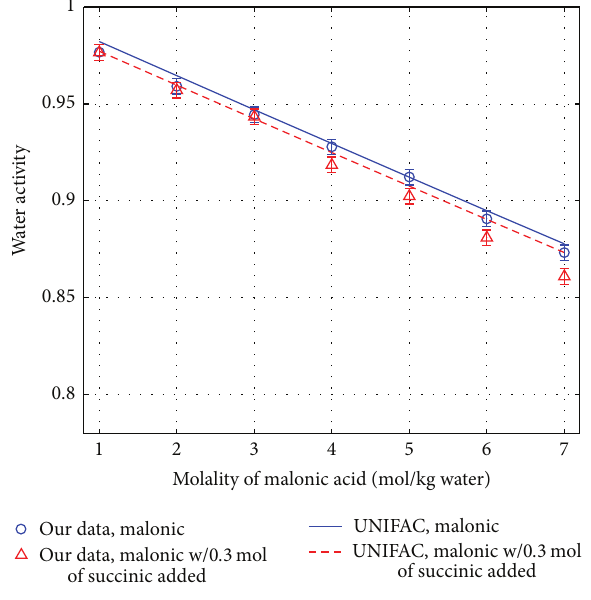
Figure 5: Water activity of glutaric acid with and without succinic acid added. Each data point represents the average of 4 replicate measurements; Error bars on measured data represent standard deviation of